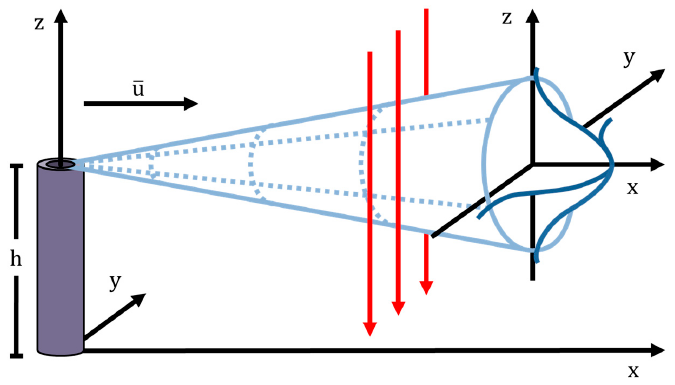
Figure 6. Measurement geometry and Gaussian plume model. The point source is located at the left at height h. Mean wind ū is in x-direction. The sub-satellite track and Lidar measurement (red arrows) is normal to it, along the y-direction. Table 3. Gaussian plume dimensions in the horizontal ( σ y , across mean wind direction) and vertical ( σ z ), as function of point source distance x and strength of atmospheric turbulence, after [38]. Moderately Unstable Slightly Unstable Neutral Atmosphere Distance from the Point Source σ y /m σ z /m σ y /m σ z /m σ y /m σ z /m x = 0.5 km